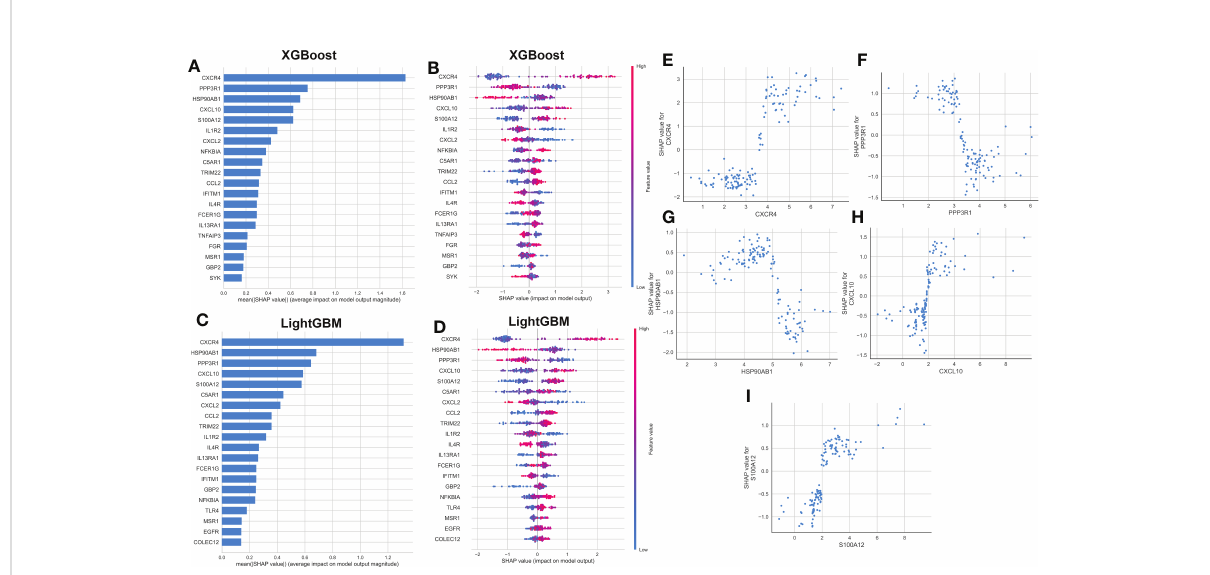
FIGURE 6 explanation of machine learning models using SHAP summary and dependence plot. (A, B) Importance matrix and SHAP summary plot showing the top 20 immune microenvironment-related genes contributing to the XGBoost model. (C, D) Importance matrix and SHAP summary plot showing the top 20 immune microenvironment-related genes contributing to the LightGBM model. Each line represented a feature variable, and the abscissa corresponded to the SHAP value. Red dots corresponded to higher feature values, and blue dots corresponded to lower feature values. (E – I) SHAP dependence plot showing the top 5 characteristic features shared by the XGBoost and LightGBM models. SHAP values more than zero represented a higher risk of